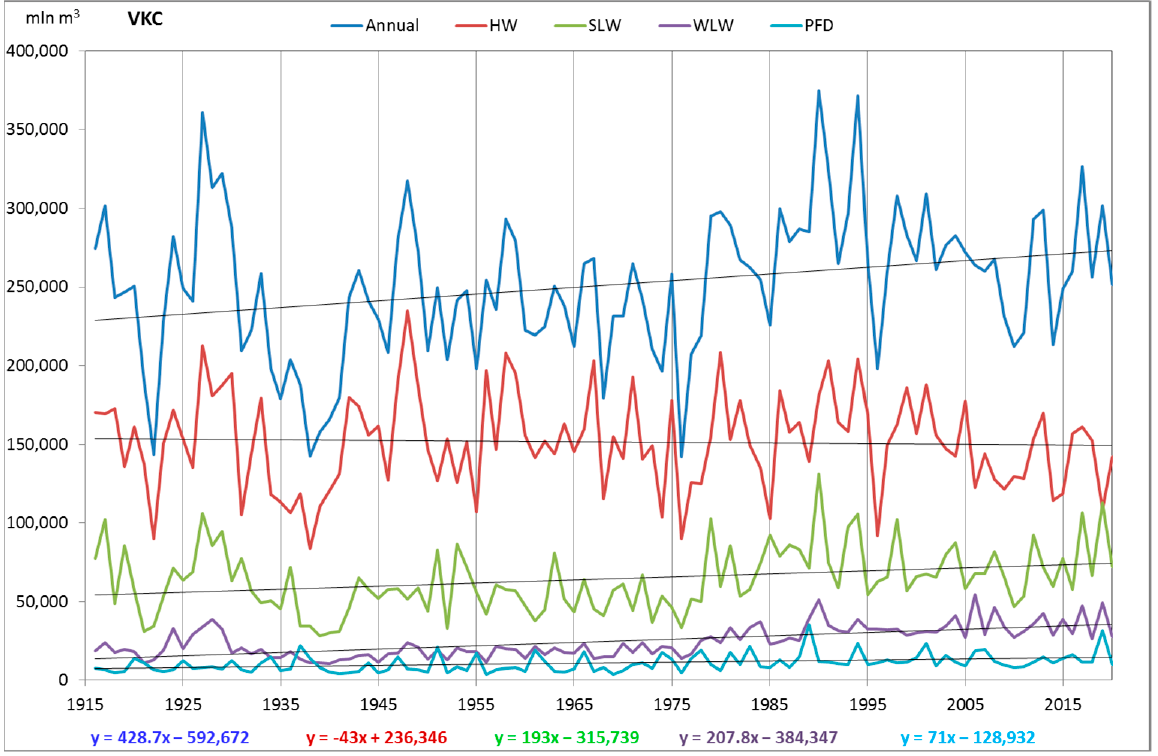
Figure 4. Annual and seasonal in fl ow—VKC.